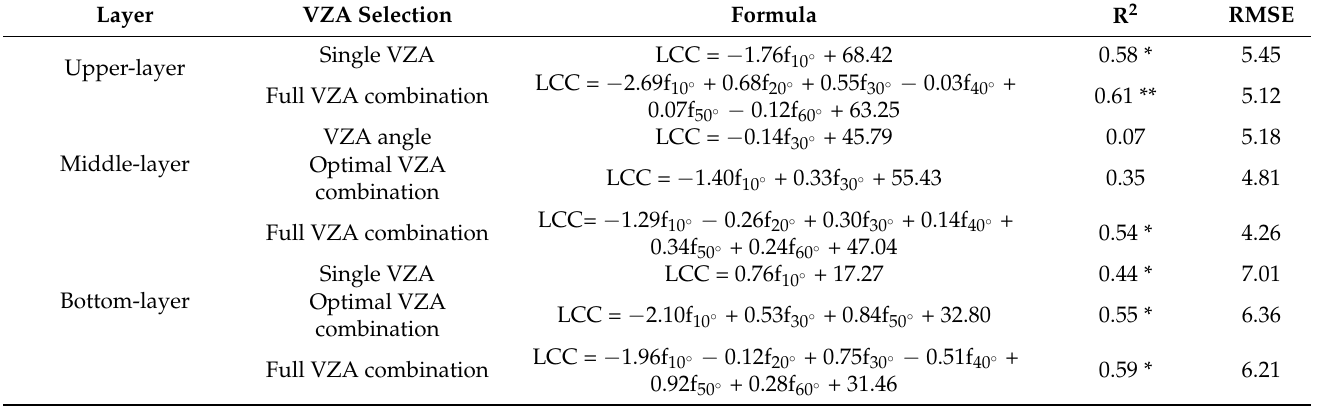
response at different VZAs (10 ◦ , 30 ◦ , and 50 ◦ ), which were shown in Tables 7 and 8. Table 7. Leaf chlorophyll content inversion strategies for the upper-, middle-, and bottom-layers using the TCARI. Layer